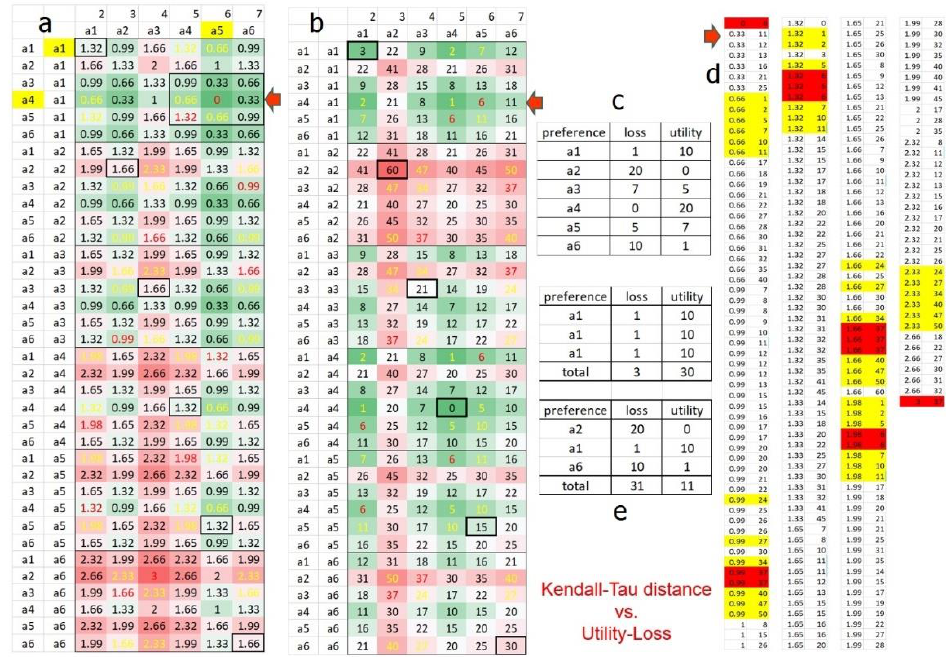
Figure 29. Conflict map vs. utility loss list. ( a ) Distance change from slack point (a4, a1, a6) to its right, ( b ) Loss change from slack point (a4, a1, a6) to its right, ( c ) Cost of staying at consensus point (a1, a1, a1), ( d ) The point couple that implies the least distance and the least loss and ( e ) The loss and profit cost calculation value for the consensus slack point (a2, a1, a6).